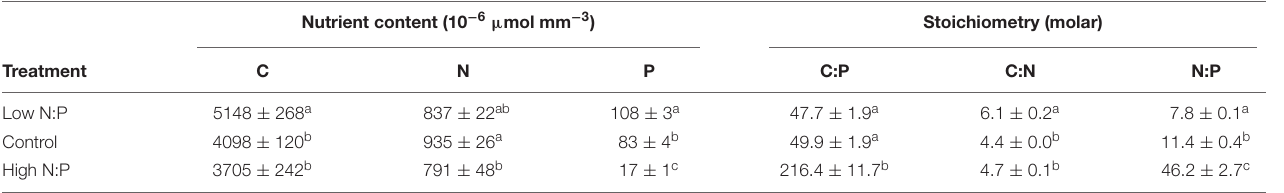
FIGURE 1 | Biovolumes of Planktothrix in the in the cultures with and without parasite exposure in the control (A) , low N:P (B) and high N:P (C) treatments. Symbols represent mean ± standard error ( n = 4). TABLE 2 | Host nutrient content and stoichiometry (mean ± SE) in unexposed